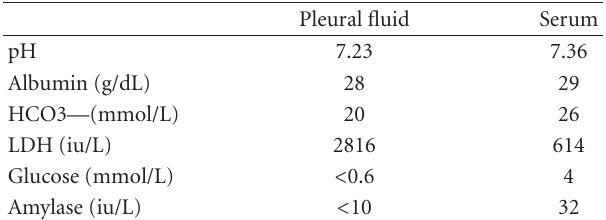
Table 3: Biochemical results. Pleural